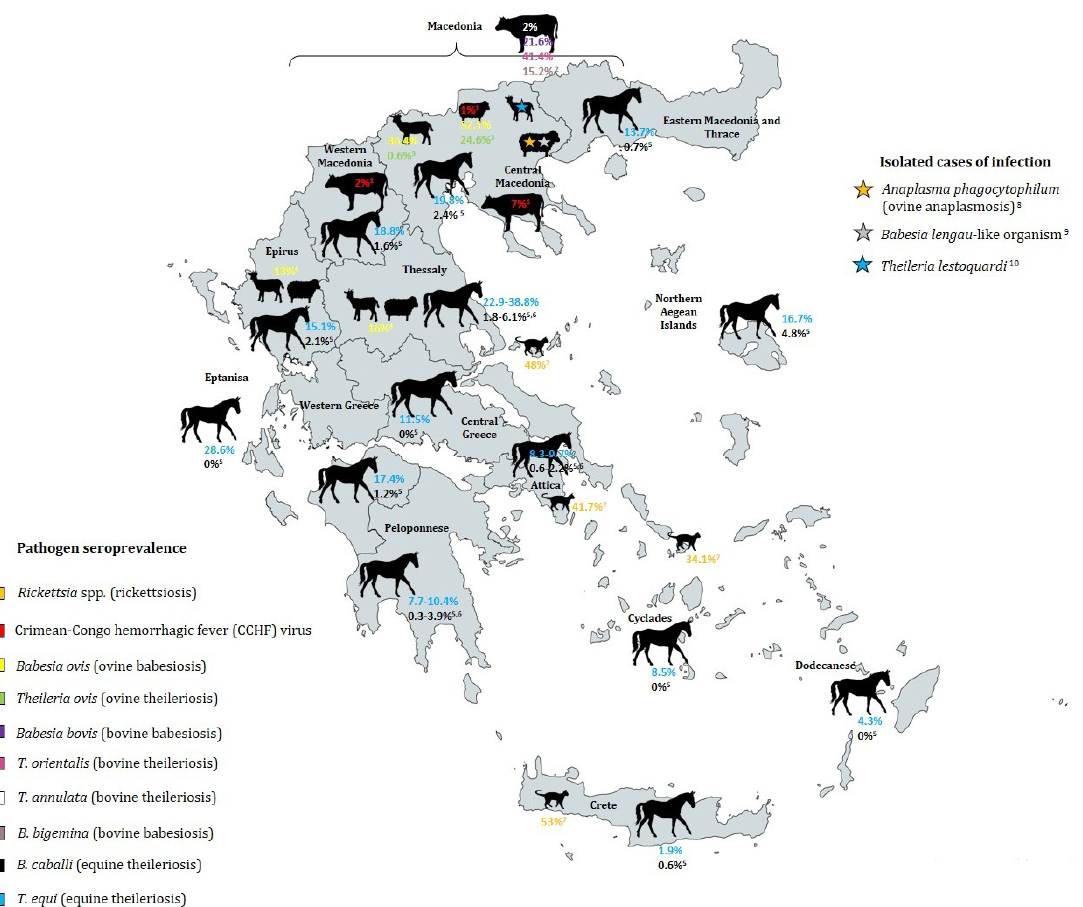
Figure 2. Map of the reported seroprevalence rates and isolated cases of various animal tick-borne diseases in different geographic regions of Greece, as described in the literature. 1 [98], 2 [80], 3 [83], 4 [82], 5 [85], 6 [84], 7 [161], 8 [78], 9 [142], 10 [87], 11 [157], 12 [158]. Map created with mapchart.net, accessed on 13 August